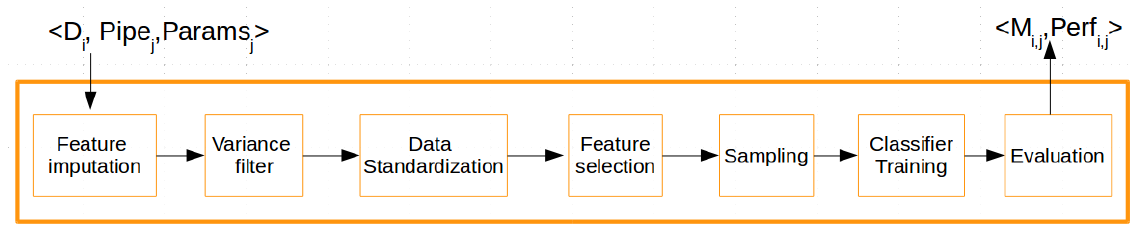
Figure 4. Pipeline Steps for early compliance classification. Table 2. Performances of the best classification models for each dataset.